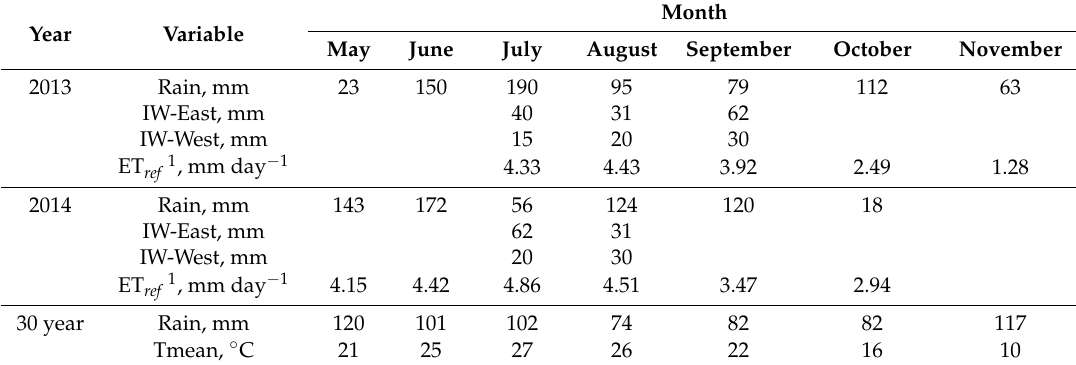
1 ET ref : Reference evapotranspiration data that were calculated using the Turc equation (Equation (3)) from 19 July 2013 (7 May 2014) to 30 November 2013 (5 October 2014), IW: irrigation water applied by the farmer. The 30-year mean data collected from the closest weather station